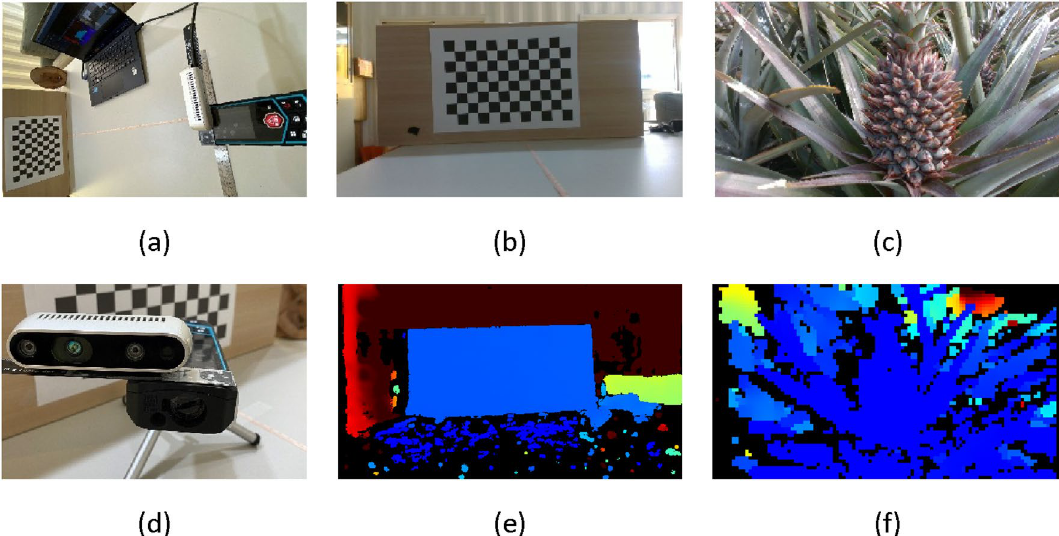
Figure 2. Distance experiment setup: ( a ) and ( d ) device architecture; ( b ) and ( e )indoor experiment; ( c ) and ( f ) field